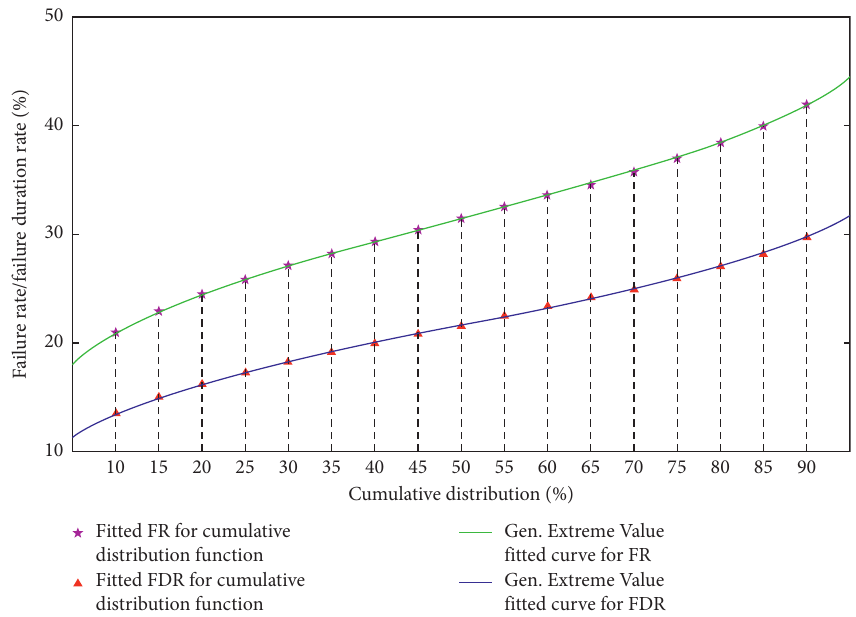
Figure 11: Correlation between fitted FR and FDR at the same CDF level using Gen. Extreme Value